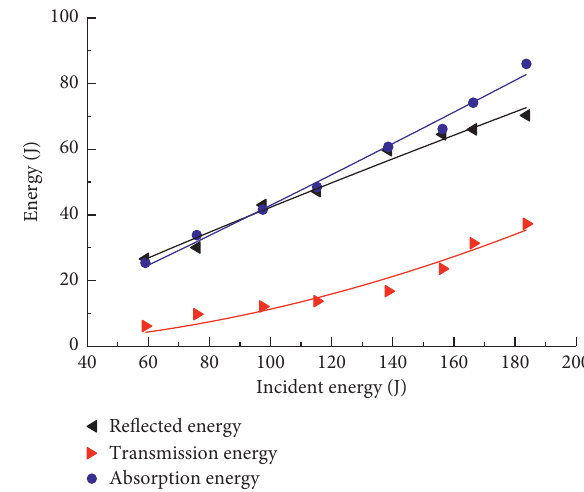
Figure 14: The relationship among reflection, transmission, ab- sorption energy, and incident